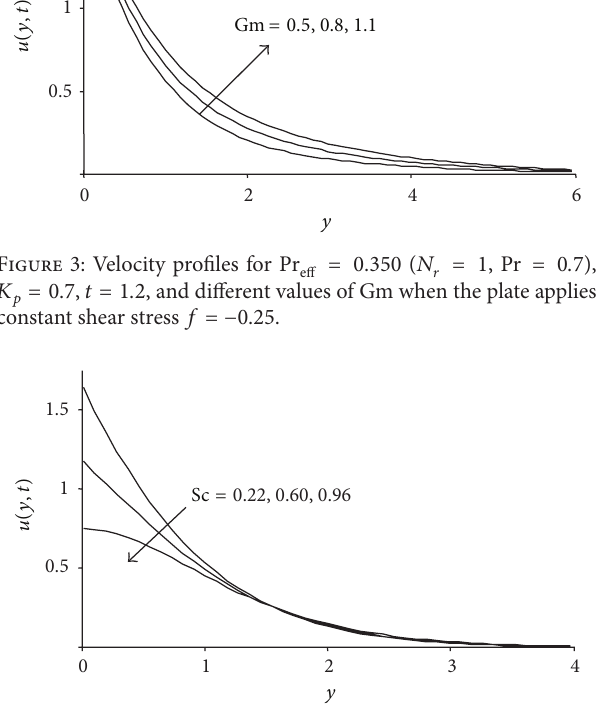
Figure 4: Velocity profiles for Pr eff = 0 . 350 ( 𝑁 𝑟 = 1, Pr = 0 . 7), = 0 . 7, 𝑡 = 1 . 2, and different values of Sc when the plate applies 𝐾 𝑝 constant shear stress 𝑓 = − 0 . 25.